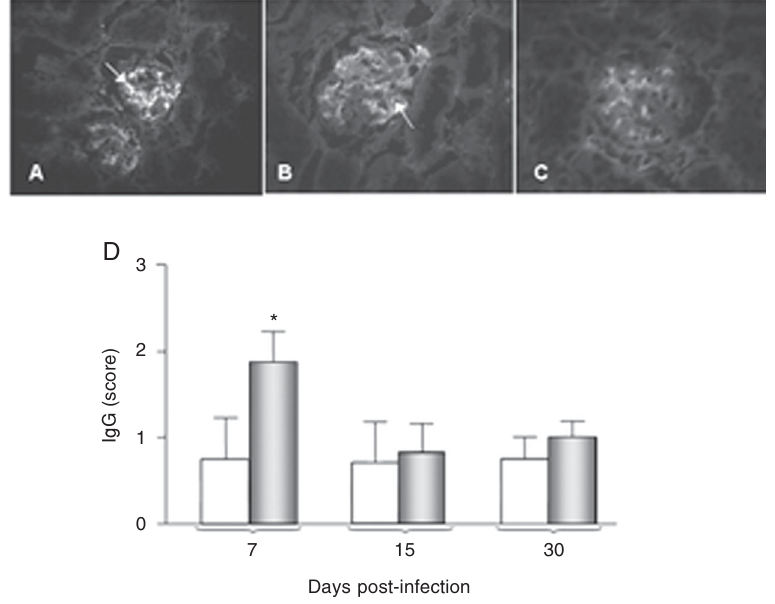
Figure 2. IgG deposits (arrow) on the glomerular capillary wall of an infected mouse. A , Presence of fluorescence of moderate intensity in the glomerular capillary wall of infected animals at 7 days post-infection (PI). B , At 15 days PI, presence of discrete fluorescence. C , Absence of IgG deposits in glomeruli of a control non-infected mouse. Indirect immunofluo- rescence (20X). D , Semi-quantitative data (score) of IgG deposits in glomeruli from BALB/c mice non-infected (N = 4) and infected with Leishmania ( L. ) chagasi (N = 8) at 7, 15, and 30 days PI. Non-infected = open columns; infected = filled columns. *P < 0.05 compared to non-infected control (ANOVA on ranks and Student-Newman-Keuls test).